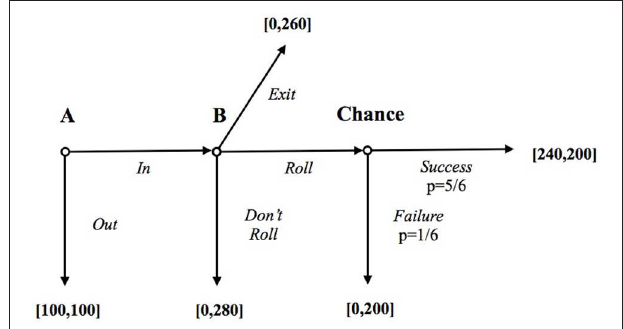
FIGURE 4 | The game with payoffs expressed in experimental tokens (conversion rate: 1 token = 0.05 e